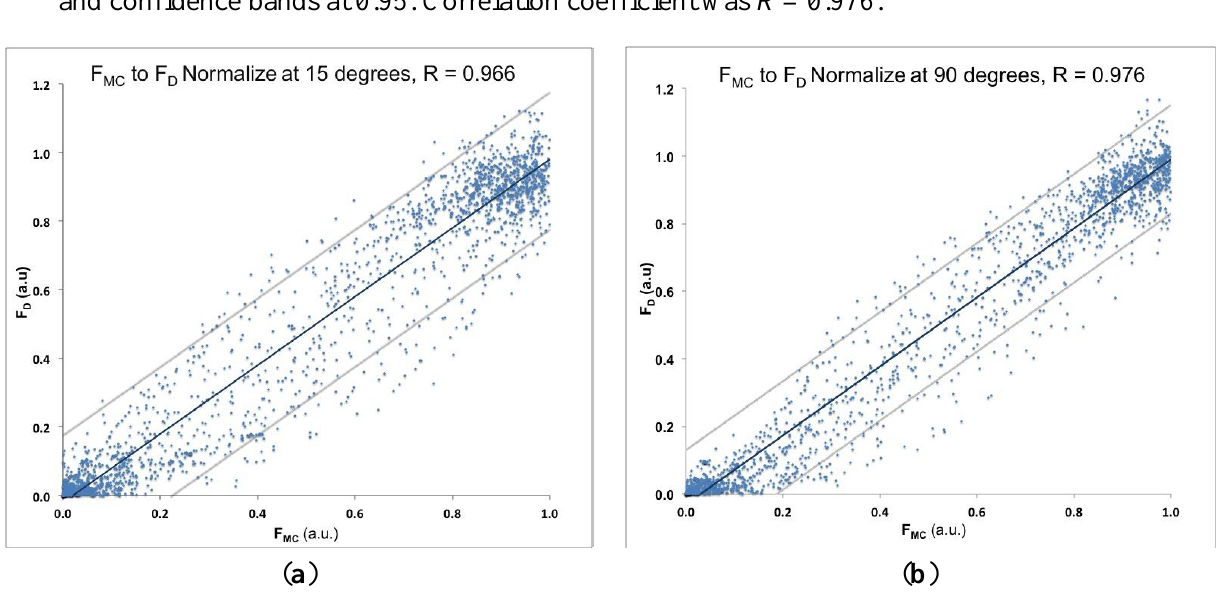
an F signal at 15° elbow flexion with MC D an F signal at 90° elbow flexion with regression line MC D